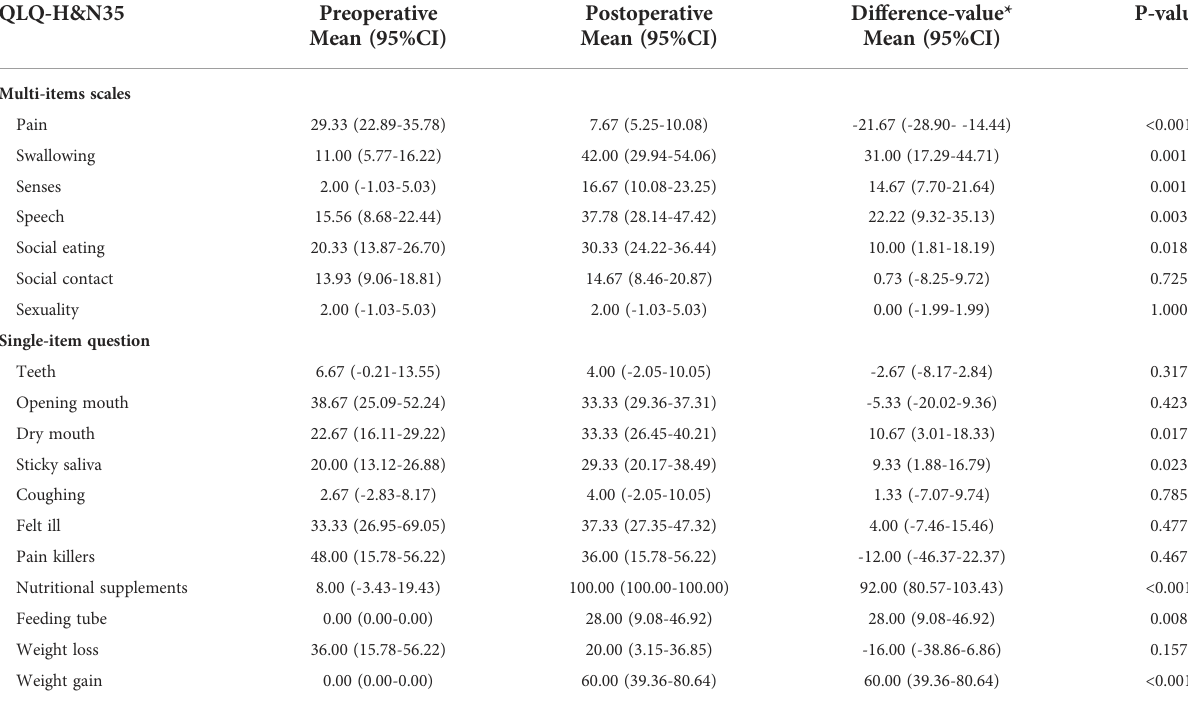
TABLE 3 Comparison of quality of life between preoperative and postoperative with EORTC QLQ-H&N35.